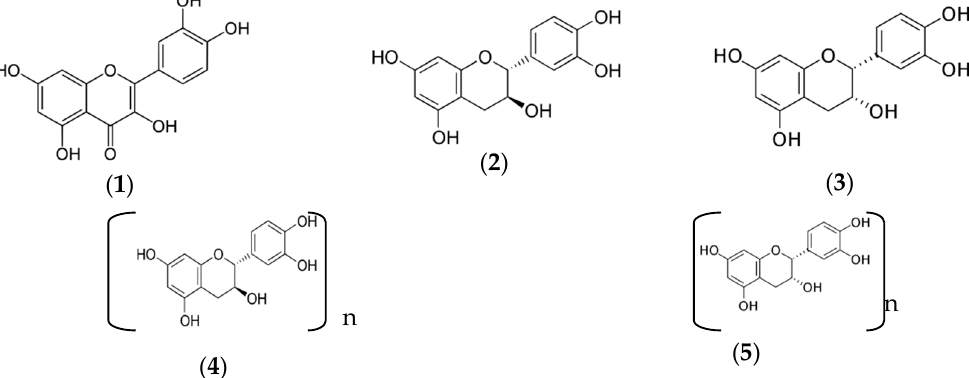
Figure 3. Chemical structures of polyphenols in the OPA-rich extract from CBS: ( 1 ) quercetin, ( 2 ) (+) catechin, ( 3 ) ( − ) epicathecin, ( 4 ) procyanidin (catechin type), and ( 5 ) procyanidin (epicatechin type). n = 2, 3, 4, 5 or 6.